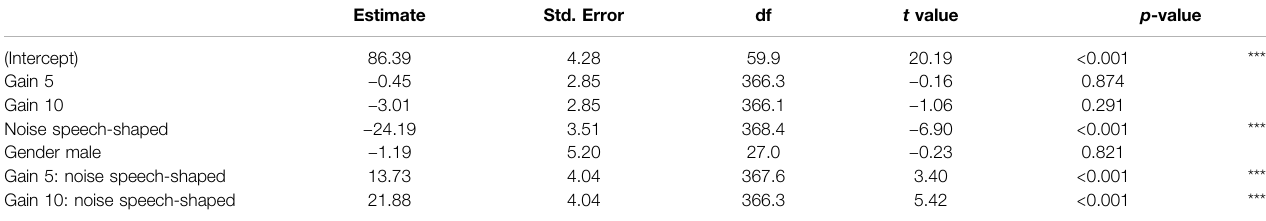
TABLE 5 | LME models fi t by REML for the response variable Control and the fi xed factors 1) gain, 2) noise, 3) gender, 4) the interaction between gain and noise.